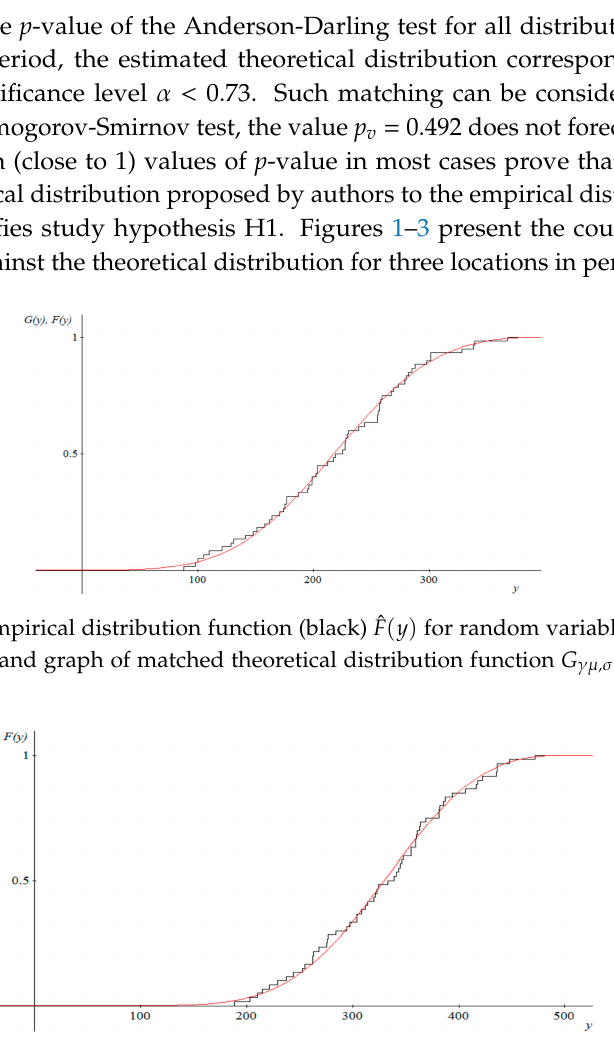
Figure 2. Graph of empirical distribution function (black) ˆ F ( y ) for random variable M 30 for period 2014–2018 in Gozdowice and graph of matched theoretical distribution function G γµ , σ ( y ) (red). Source: Own